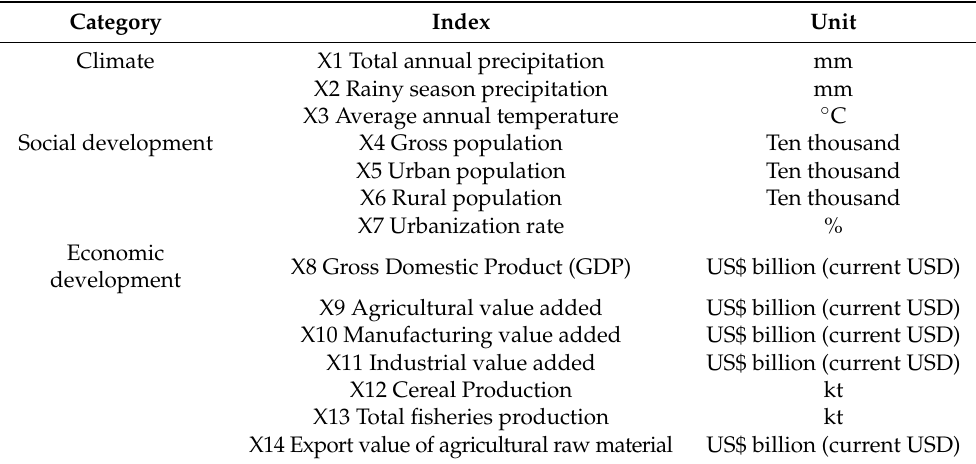
Table 3. Indicators and their categories of economic and social development statistics from 2000 to